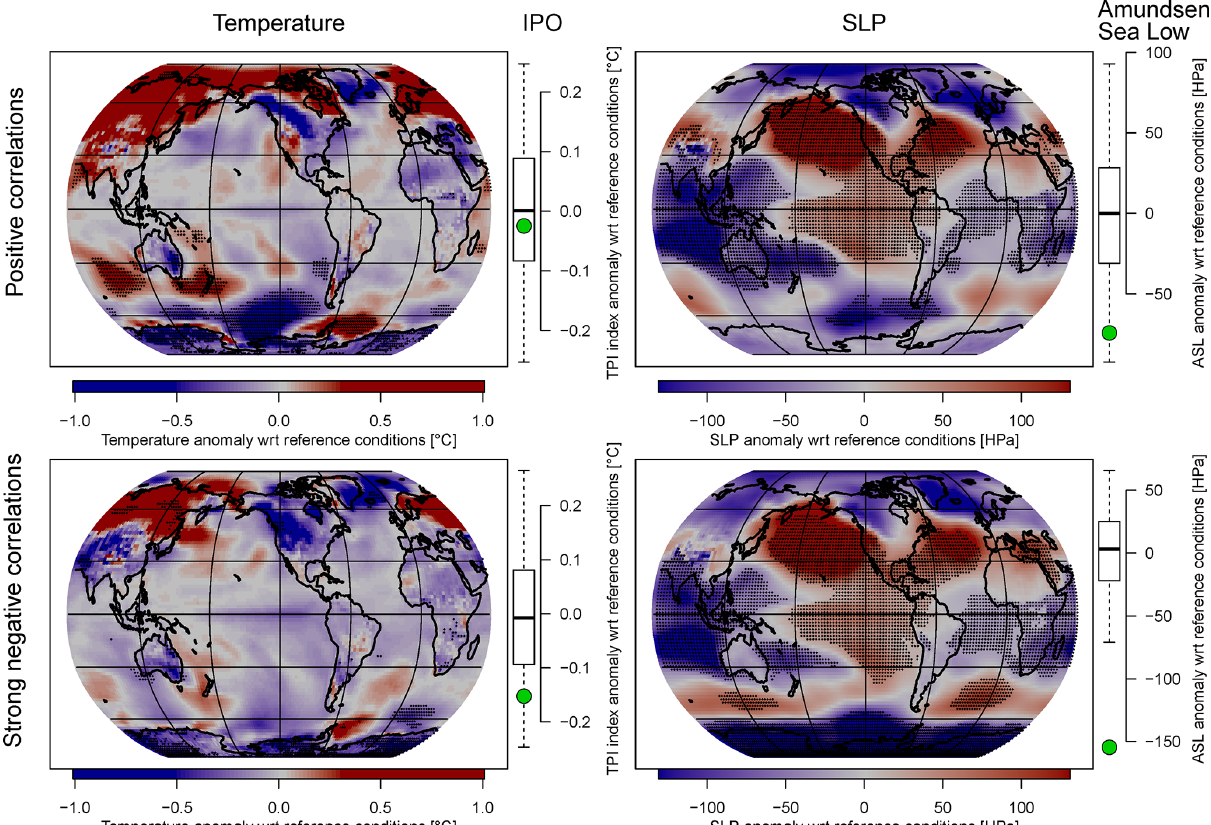
Figure 5. Simulated climate anomalies during years of positive (top row) and particularly strong negative (bottom row) ENSO–SAM correla- tions for which ENSO and SAM were both in their positive or both in their negative phase (see Methods section for details). Left maps: surface temperature anomalies. Left box-and-whisker plots: IPO anomalies. Right maps: SLP anomalies. Right box-and-whisker plots: ASL anoma- lies. Black stippling in the maps represents significant values. Bold lines in the boxplots represent the median of random-sampled anomalies, boxes the interquartile range and whiskers the 95% range. Green circles represent the average anomalies during years of positive or strong negative ENSO–SAM correlations. Note that for temperature (SLP), values where ENSO and SAM are in their negative (positive) phase were multiplied by − 1. This means that in case of temperature (SLP) the patterns shown in the figure reflect ENSO + /SAM + (ENSO − /SAM − )